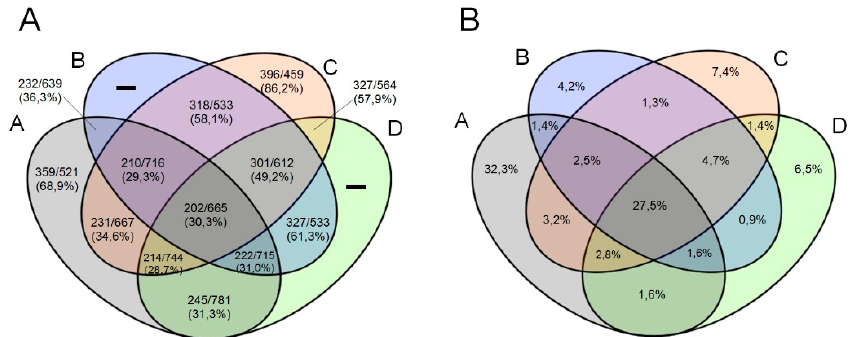
Figure 2. Distribution of orthologous gene clusters among marseillevirus lineages ( A ) and the proportion of orthologous gene clusters shared between and within lineages ( B ). For these analyses, we used the genome content of viruses from lineage A (Marseillevirus, Cannes8 virus, Melbournevirus and Senegalvirus), lineage B (Lausannevirus), Lineage C (Tunisvirus and Insectomime virus), and Lineage D (BrMV). The letters at each ellipsis’s top are related to the marseillevirus lineages A–D.